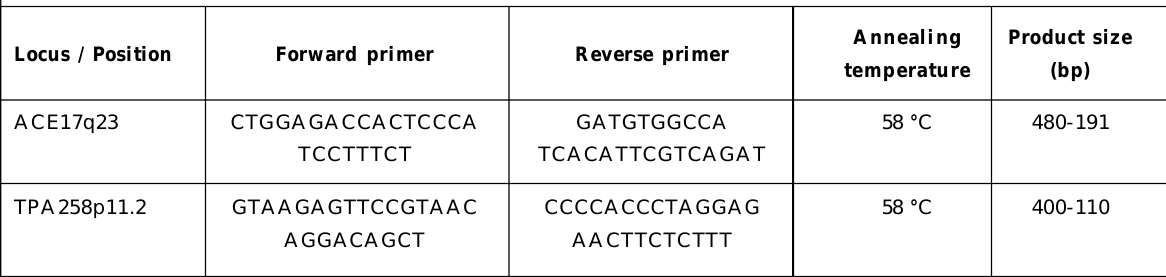
Table 1: Locus characteristics, primer sequences, annealing temperatures, and PCR product size for genetic Alu elements in seven